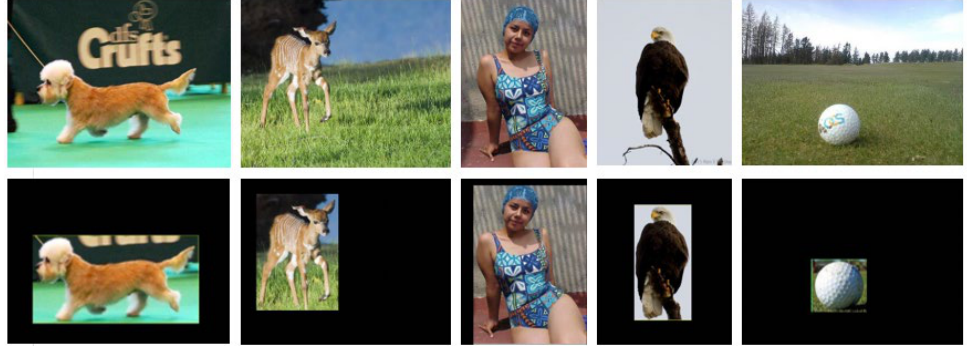
Figure 2. Some sample images with salient objects after preprocessing module.